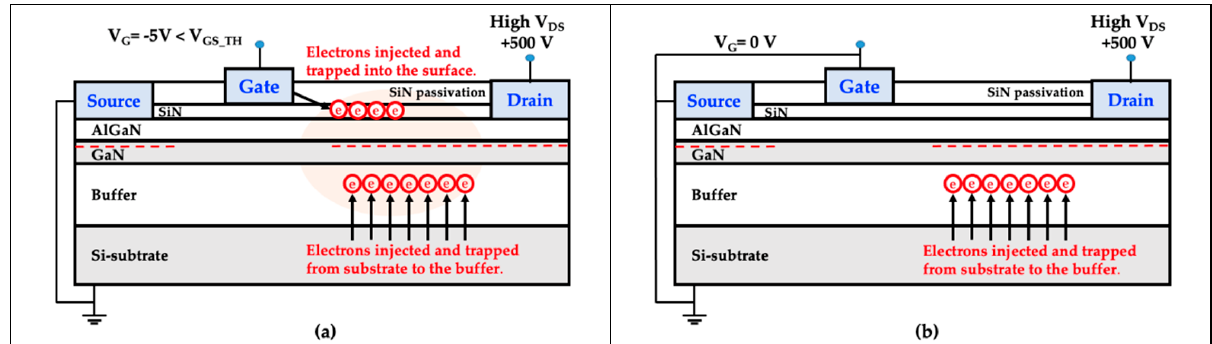
Figure 6. A schematic representation of the trapping processes in the analysed GaN HEMTs during the two off-state stresses. ( a ) Whit negative gate voltage. ( b ) Whit zero gate voltage